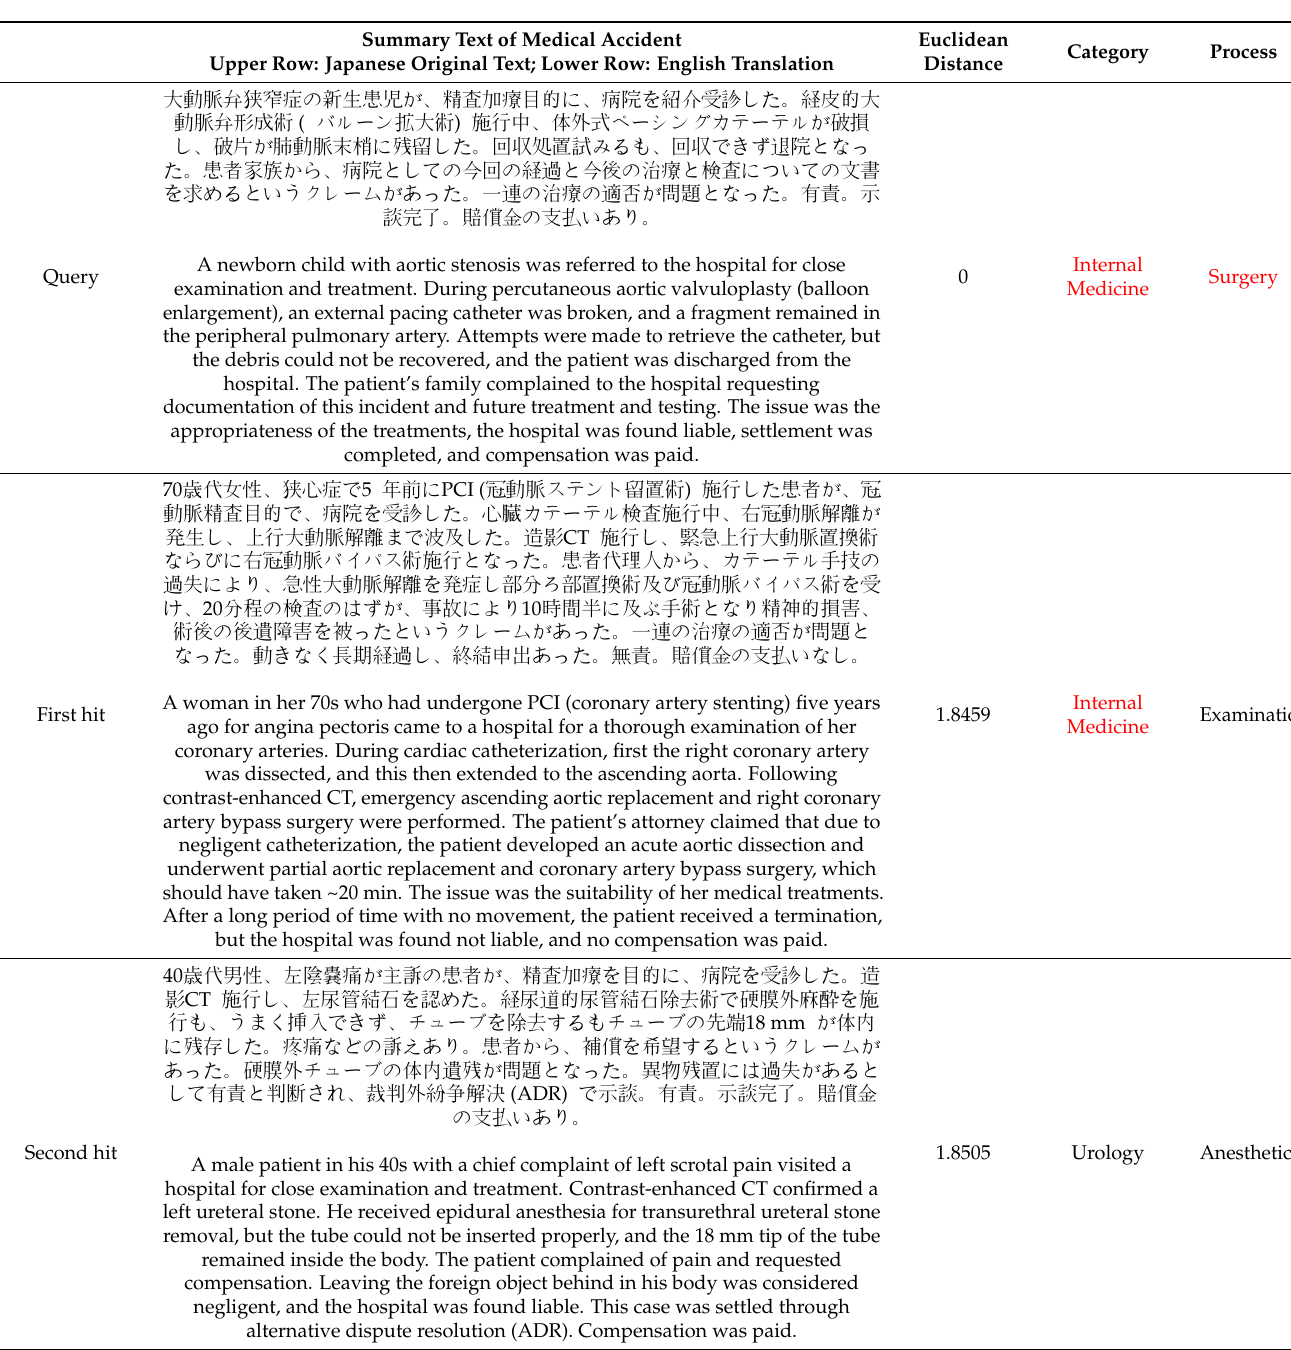
Table 4. An example results of a similar text search by the PRETRAINED SBERT with the UTH-BERT model. The labels in red are those that match the labels in the